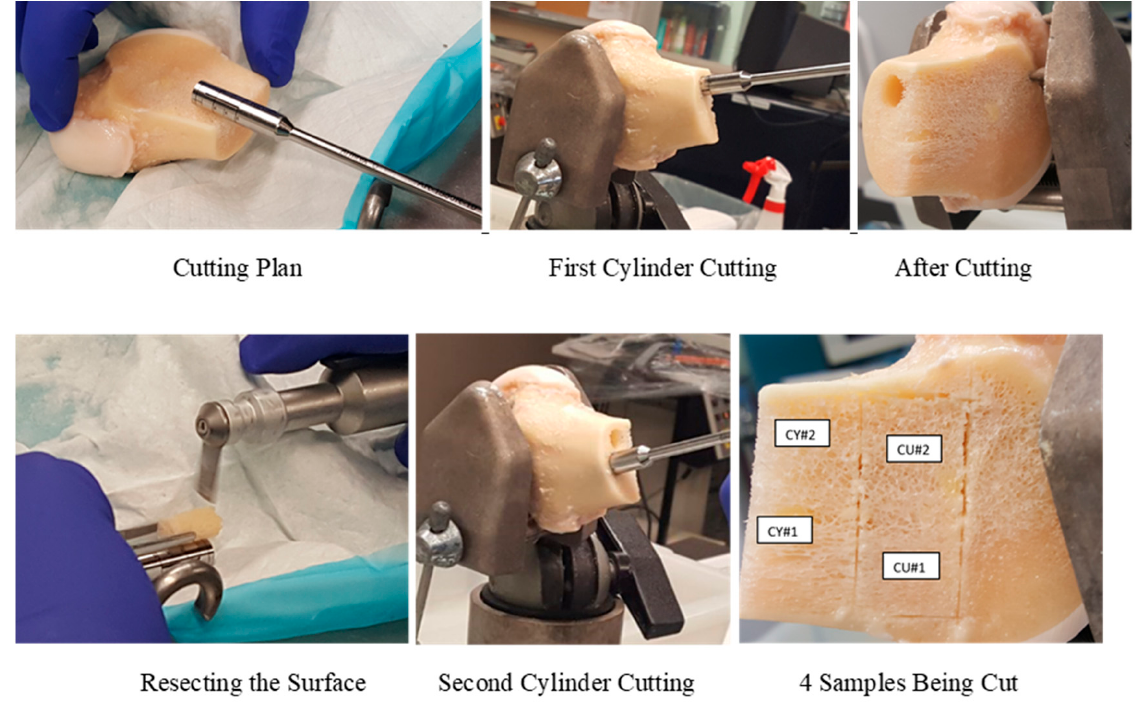
Figure 1. Preparation of the trabecular bone samples.